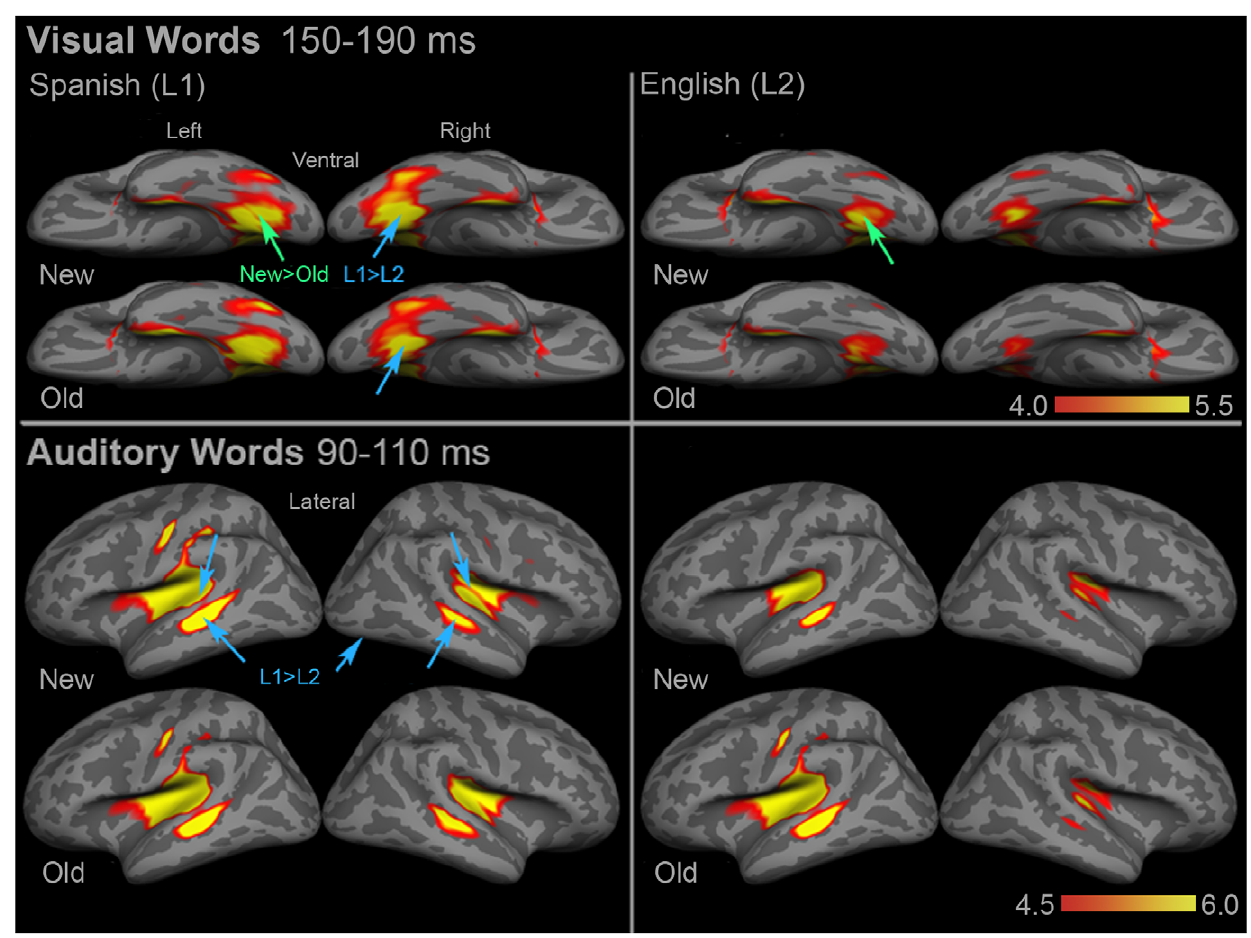
Figure 2. Group dSPM of the mean activity during early visual (top) and auditory (bottom) word encoding. In both modalities, activity appears to be strongly lateralized for English but largely bilateral for Spanish. For visual words, left VOT showed a marginal repetition effect (green arrows), and right VOT showed a trending Spanish . English language effect (blue arrows). For auditory words, right planum temporale, bilateral anterior STS, and right posterior fusiform showed Spanish . English effects (blue arrows). Left planum temporale showed a trending Spanish . English effect. See Supplementary Figure S2 for ROI locations and names. Color bars represent square root of F values, which are a measure of signal-to- noise.